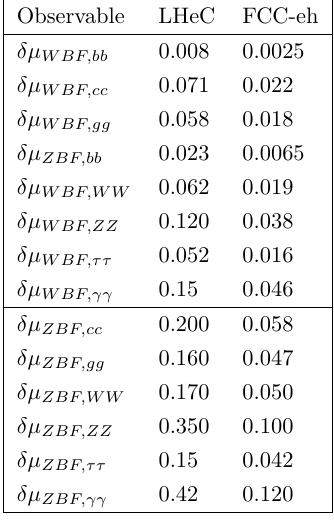
Table 24 . Inputs used for LHeC and FCC-eh projections. All uncertainties are given as fractional 68% CL intervals and are taken to be symmetric.